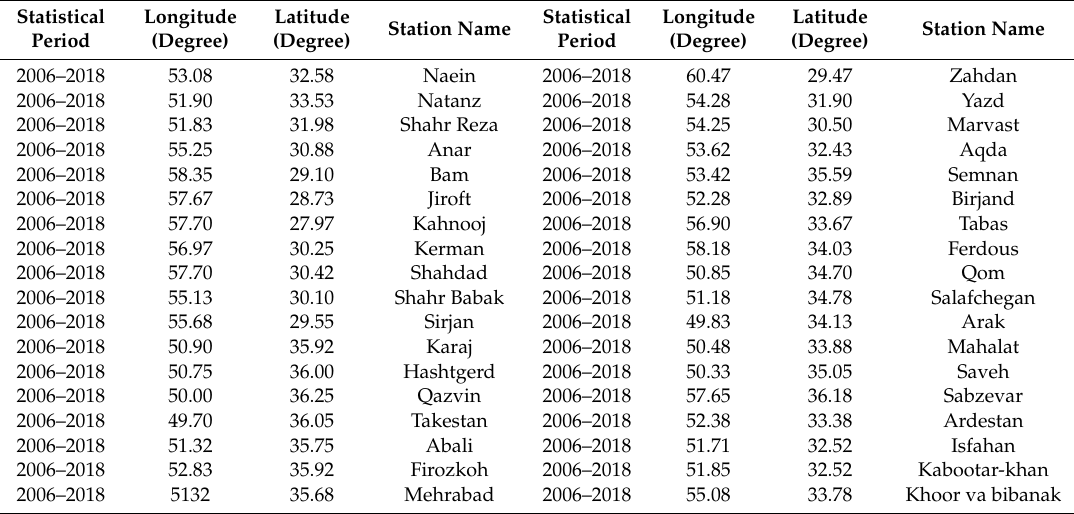
Table 2. Information on synoptic stations in the study